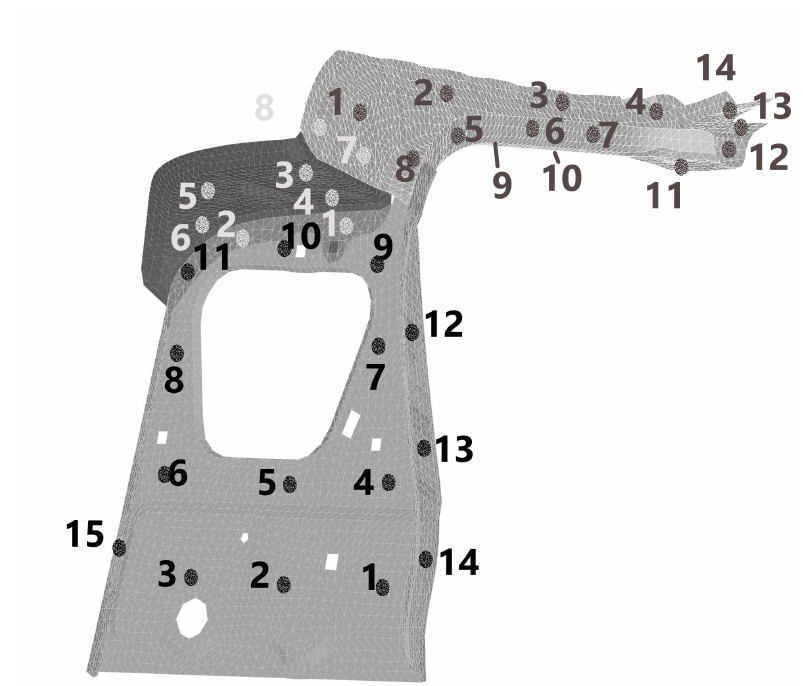
Figure 6. The representative locating points for fixture layout